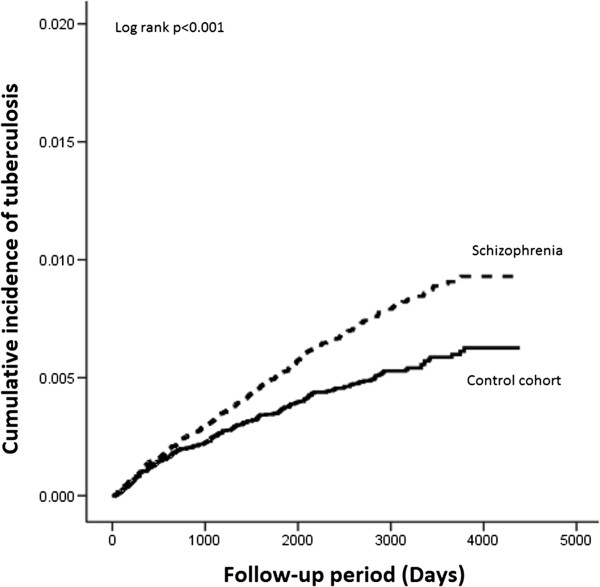
Kaplan-Meier plots of the cumulative incidence of tuberculosis between schizophrenics and control cohort.